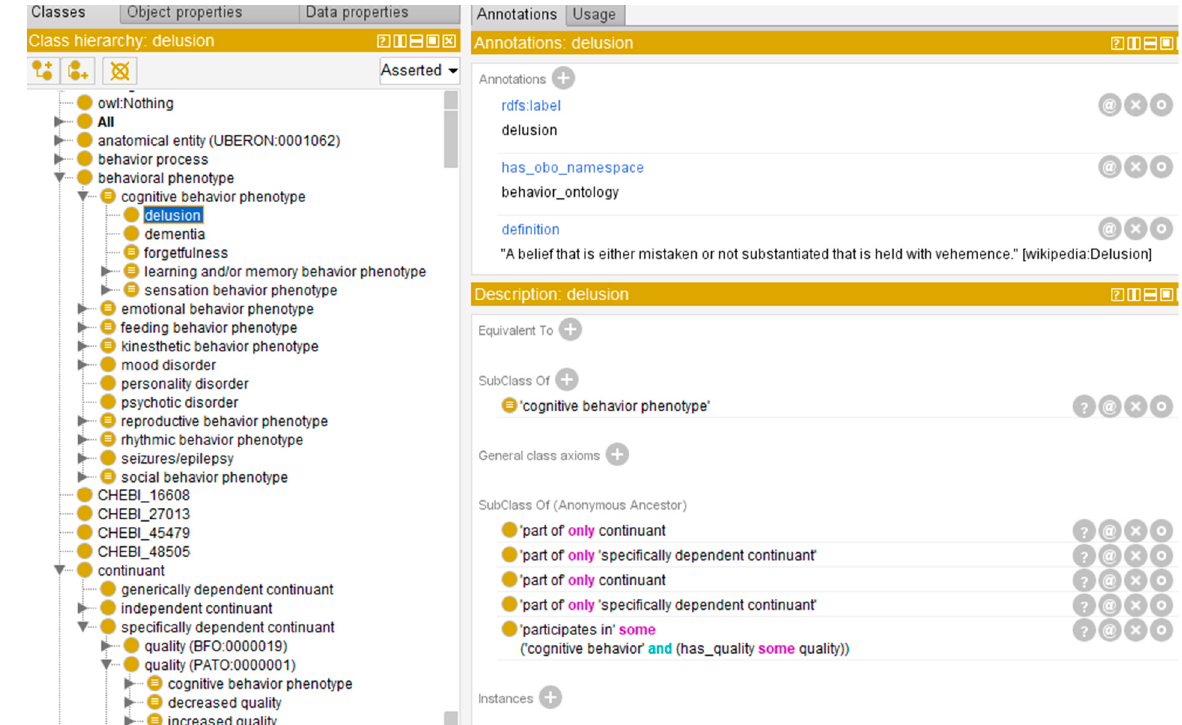
Figure 1. Protégé Entity Browser: List and details subviews loaded with the Human Phenotype Ontology. Source: Image with permission courtesy of Center for Biomedical Informatics Research, Stanford University School of Medicine, Protégé Team, https://protege.stanford.edu.